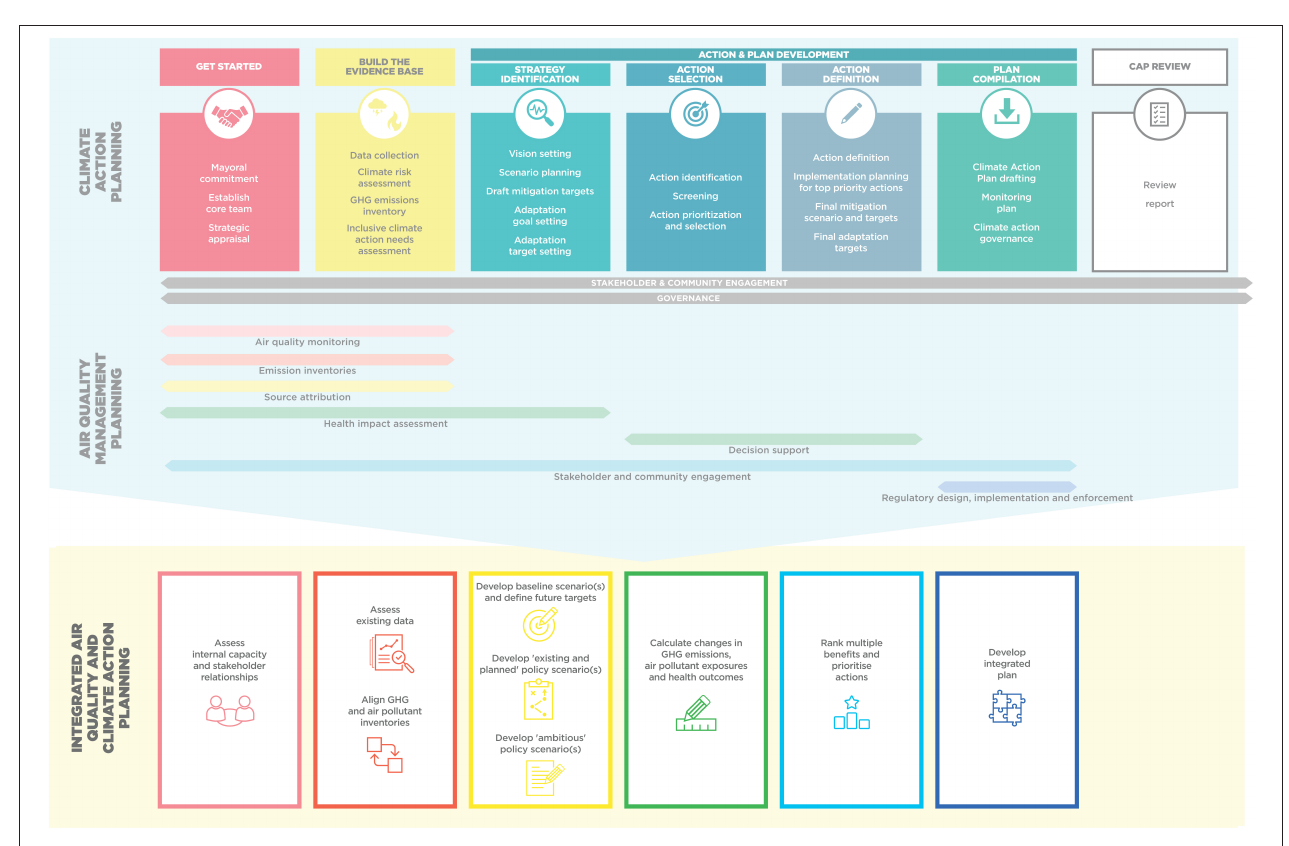
FIGURE 2 | Flow diagram of C40 integrated climate and air quality (CAP-AQ) assessment